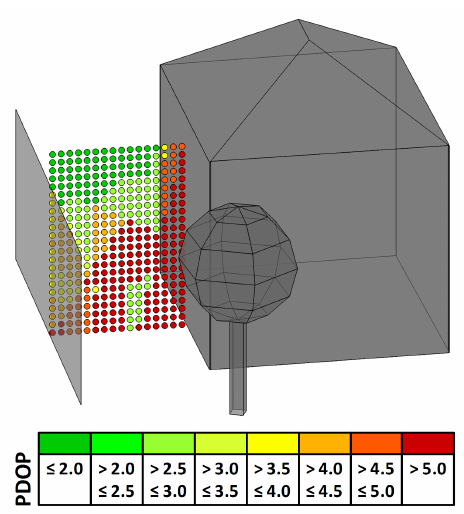
Figure 3. Site-dependent PDOP values (colored dots) for a UAV trajectory along a building (right) and a simplified representation of vegetation (left wall)